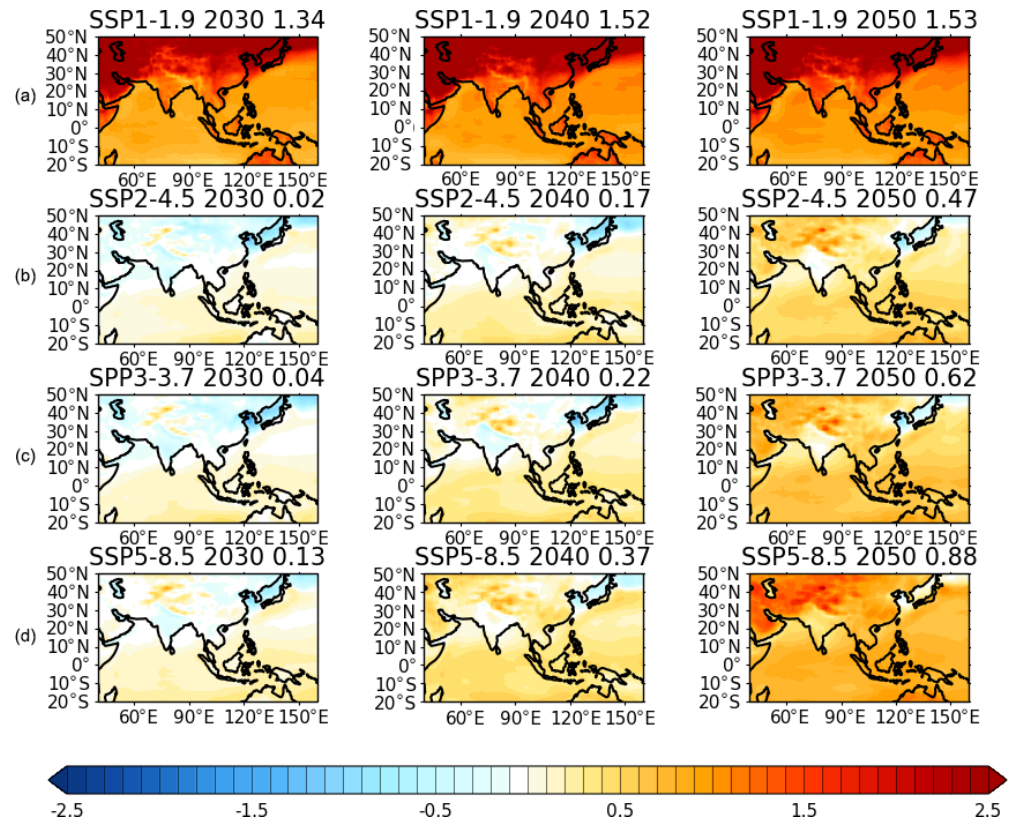
Figure 9. (a) CMIP6-mean JJA-mean near-surface temperature anomaly (K) for 2025–2034, 2035–2044, and 2045–2054 vs. 1980–2014 from SSP1-1.9. Relative anomalies for (b) SSP2-4.5, (c) SSP3-7.0, and (d) SSP5-8.5 vs. SSP1-1.9. The numbers shown at the top right of each panel are the Asian mean, where Asia is the region bounded by 5–47.5 ◦ N, 67.5–145 ◦